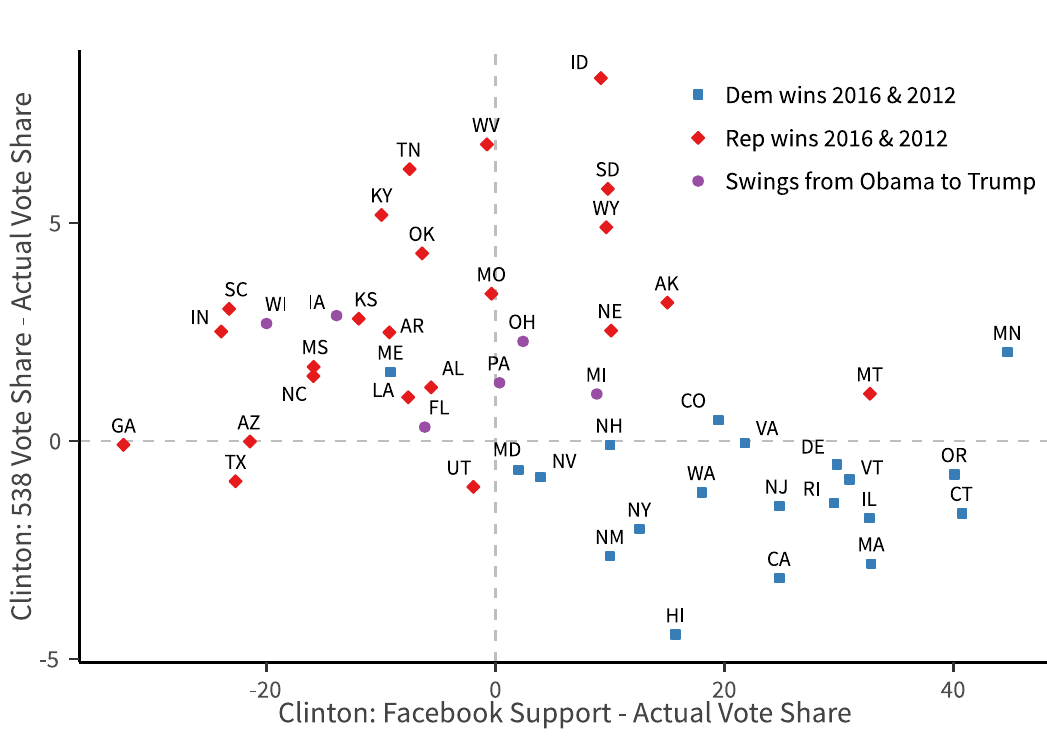
Fig 16. Compare clinton’s Facebook support rate and polling-based predicted vote share with actual vote share. Facebook support rate: Share of user’s ideology closer to Clinton, using data one month before the week of election (2016-10-09 to 2016-11- 05). 538 Polling Average: “Nowcast” for 2016-11-08 from [27].